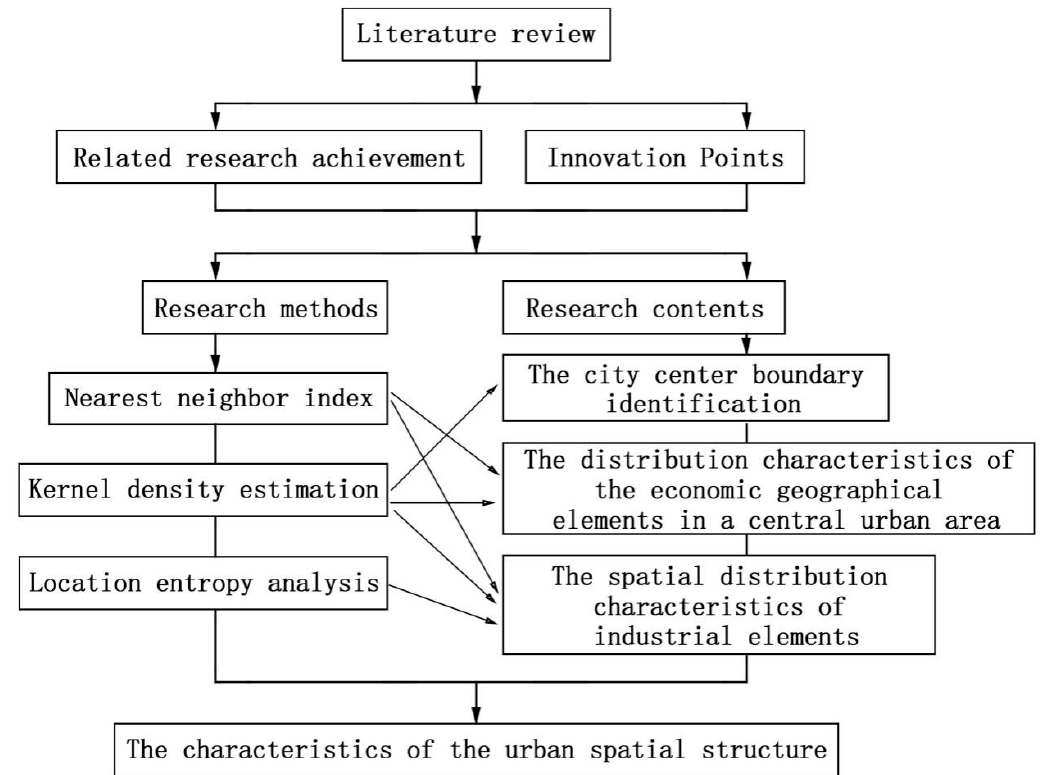
Figure 1. Technology Figure 1. T echnology roadmap.